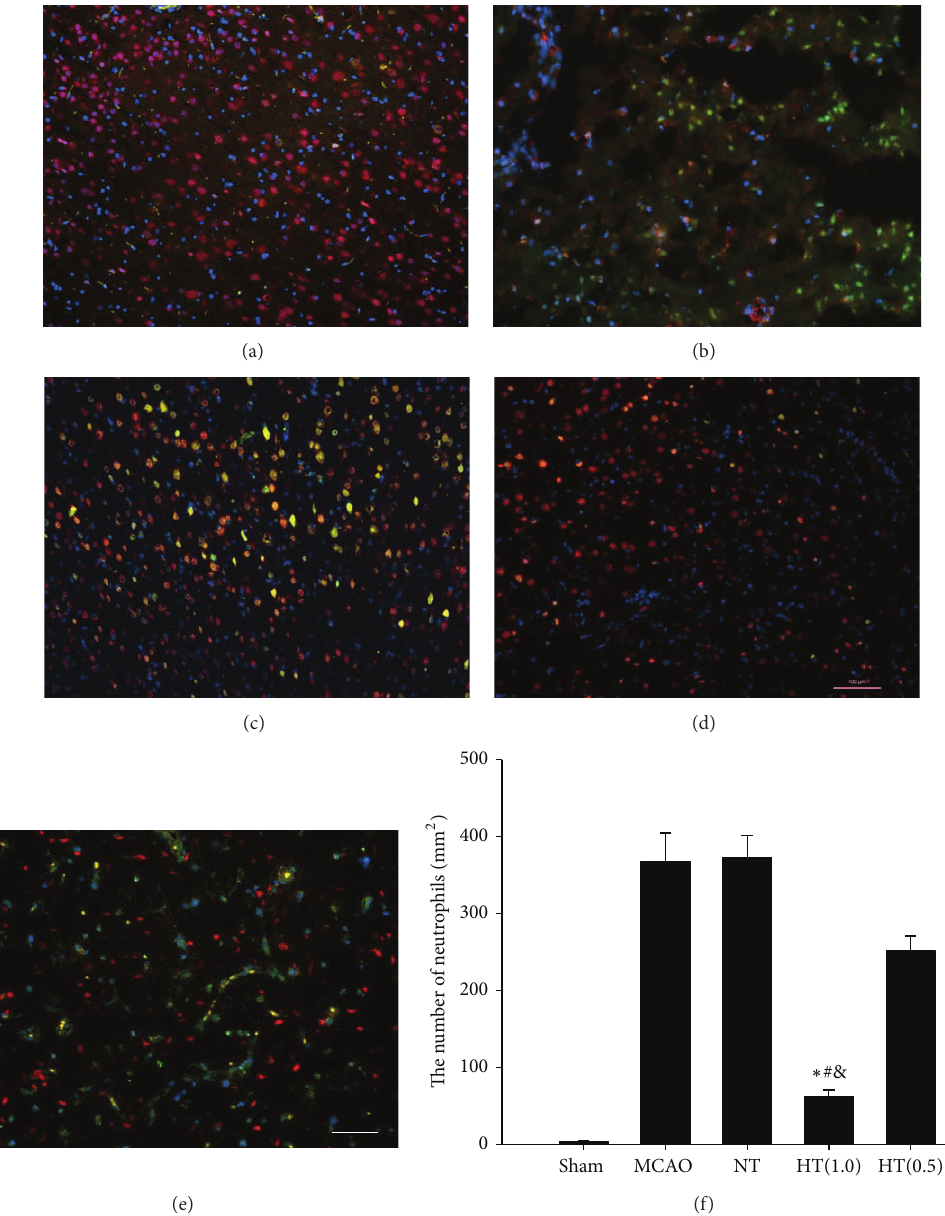
Figure 5: AIH decreases levels of neutrophil elastase expression in the infarcted brain. Coronal sections 24 h after operation were stained with specific antibodies: neutrophil elastase (green) and NeuN (red). The mounting medium contained DAPI, which counterstained the nuclei (blue). The merged images show the coexpression of NeuN and neutrophil elastase in yellow (a–e). Scale bar = 100 𝜇 m. (f) Neutrophil elastase-positive cells were quantitatively analyzed using ImageJ software. All values are the mean ± SEM. ∗ 𝑃 < 0.05 compared to the MCAO group, # 𝑃 < 0.05 compared to the NT group, and & 𝑃 < 0.05 compared to the HT(0.5)